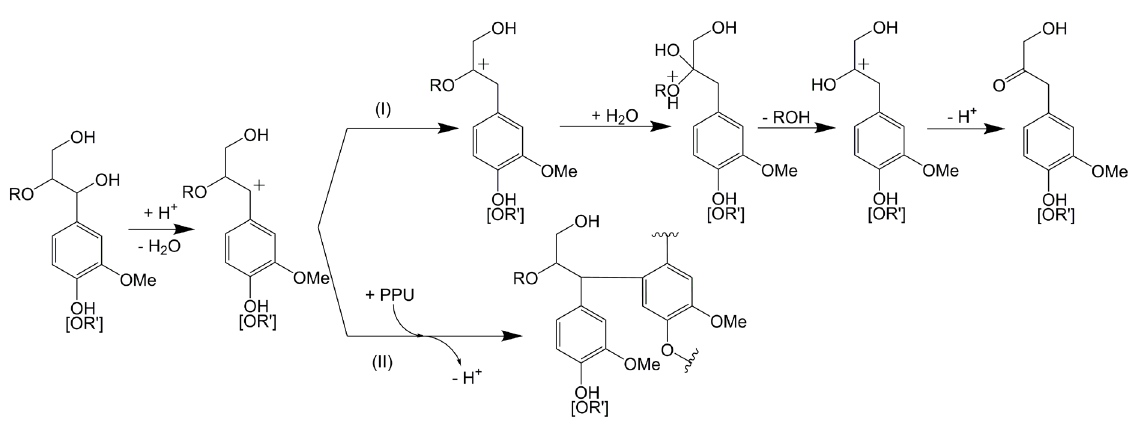
Figure 9. Reactions of PPUs at lignin pyrolysis in the presence of acid catalysts (R and R’ – neighbor